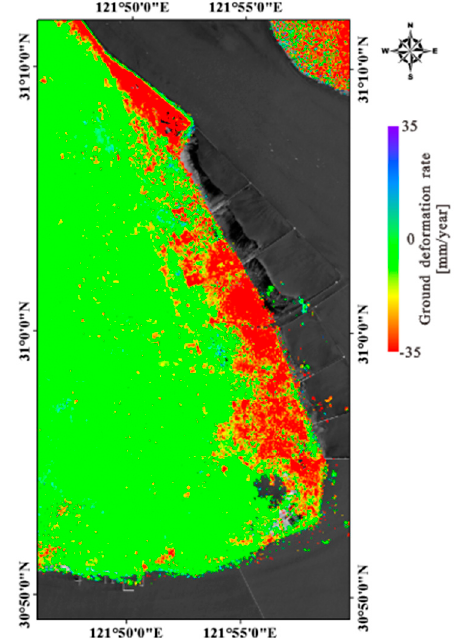
Figure 6. Ground deformation rate in the reclamation area.